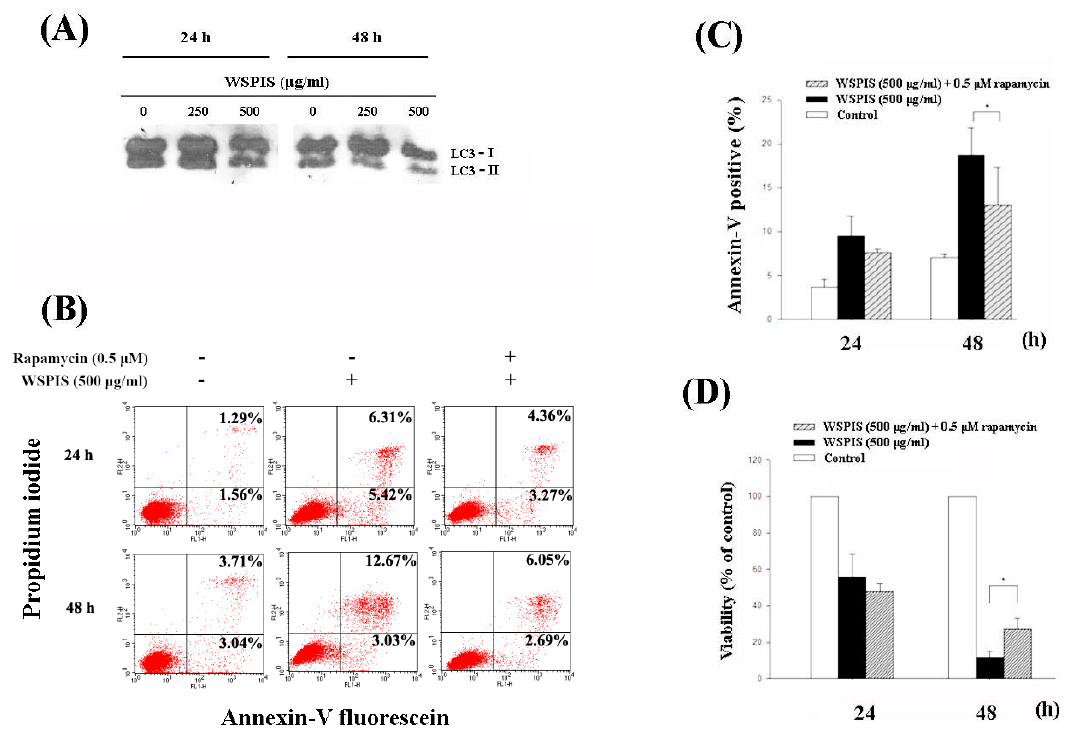
Figure 7. WSPIS inhibited autophagy. ( A ) Cells were treated with various concentrations of WSPIS (250 and 500 µ g/mL) for 24 h and 48 h. The protein levels of LC3-I and LC3-II were measured by Western blotting. ( B ) Autophagy induction by rapamycin partially rescued WSPIS-induced apoptosis. THP-1 cells were pretreated with rapamycin (0.5 µ M) for 1 h, followed by 500 µ g/mL WSPIS treatment for 24 and 48 h. Apoptotic cells were analyzed by using flow cytometry after annexin-V/propidium iodide staining. ( C , D ) Rapamycin partially rescued WSPIS-induced apoptosis and cell death after 48 h treatment. Apoptosis and cell viability are expressed as mean ± SD of three independent experiments. Cell viability was determined by trypan blue staining. * denotes the data that are significantly different between WSPIS-only and WSPIS-combined rapamycin groups at p < 0.05.